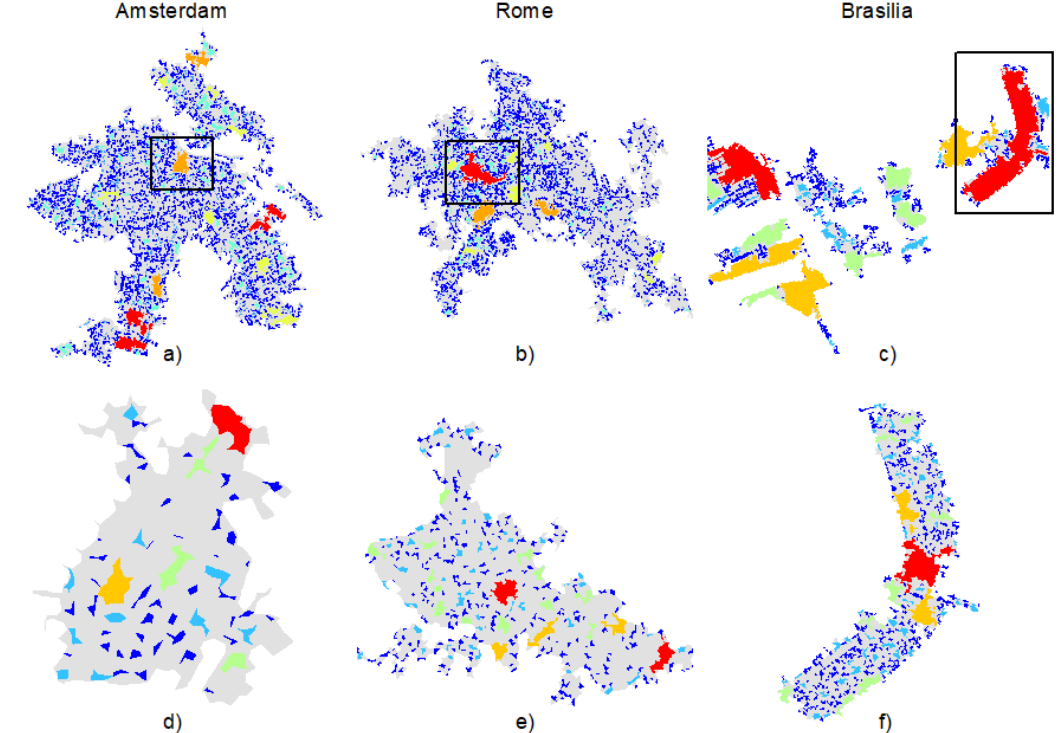
Figure 4. Recursive natural city analysis. In panels ( a – c ), the natural cities of Amsterdam, Rome, and Brasilia are shown with their hotspots. In panels ( d – f ), the microspots in their main hotspots are chosen. For Rome and Brasilia, they match the biggest hotspot. In Amsterdam, the hotspot laying over the center is chosen instead of the largest one, as denoted by the black boxes in the first three panels.